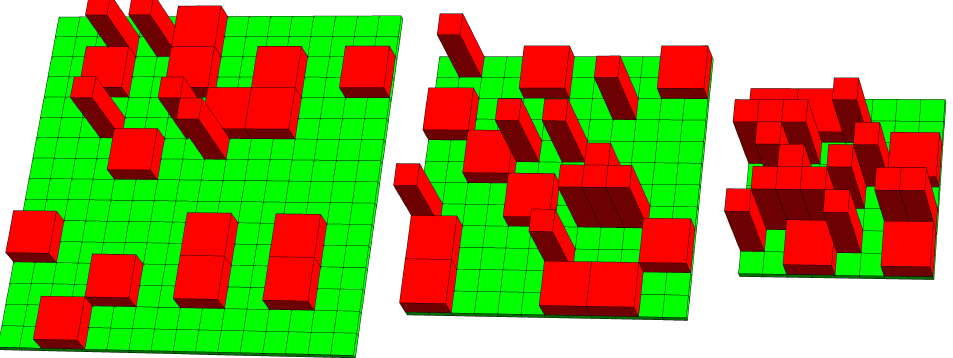
Figure 1. Schematic illustration of an air–water interface, represented by the green-colored lattice that hosts a monolayer of amphiphiles or surface-active molecules (colored red) in two conformations: one that is oriented horizontally and another one vertically to the lattice. As the available area of the monolayer shrinks due to a larger lateral pressure (from the left to the right diagram), more molecules are forced to adopt the vertical orientation, even if the reorientation is associated with an energy